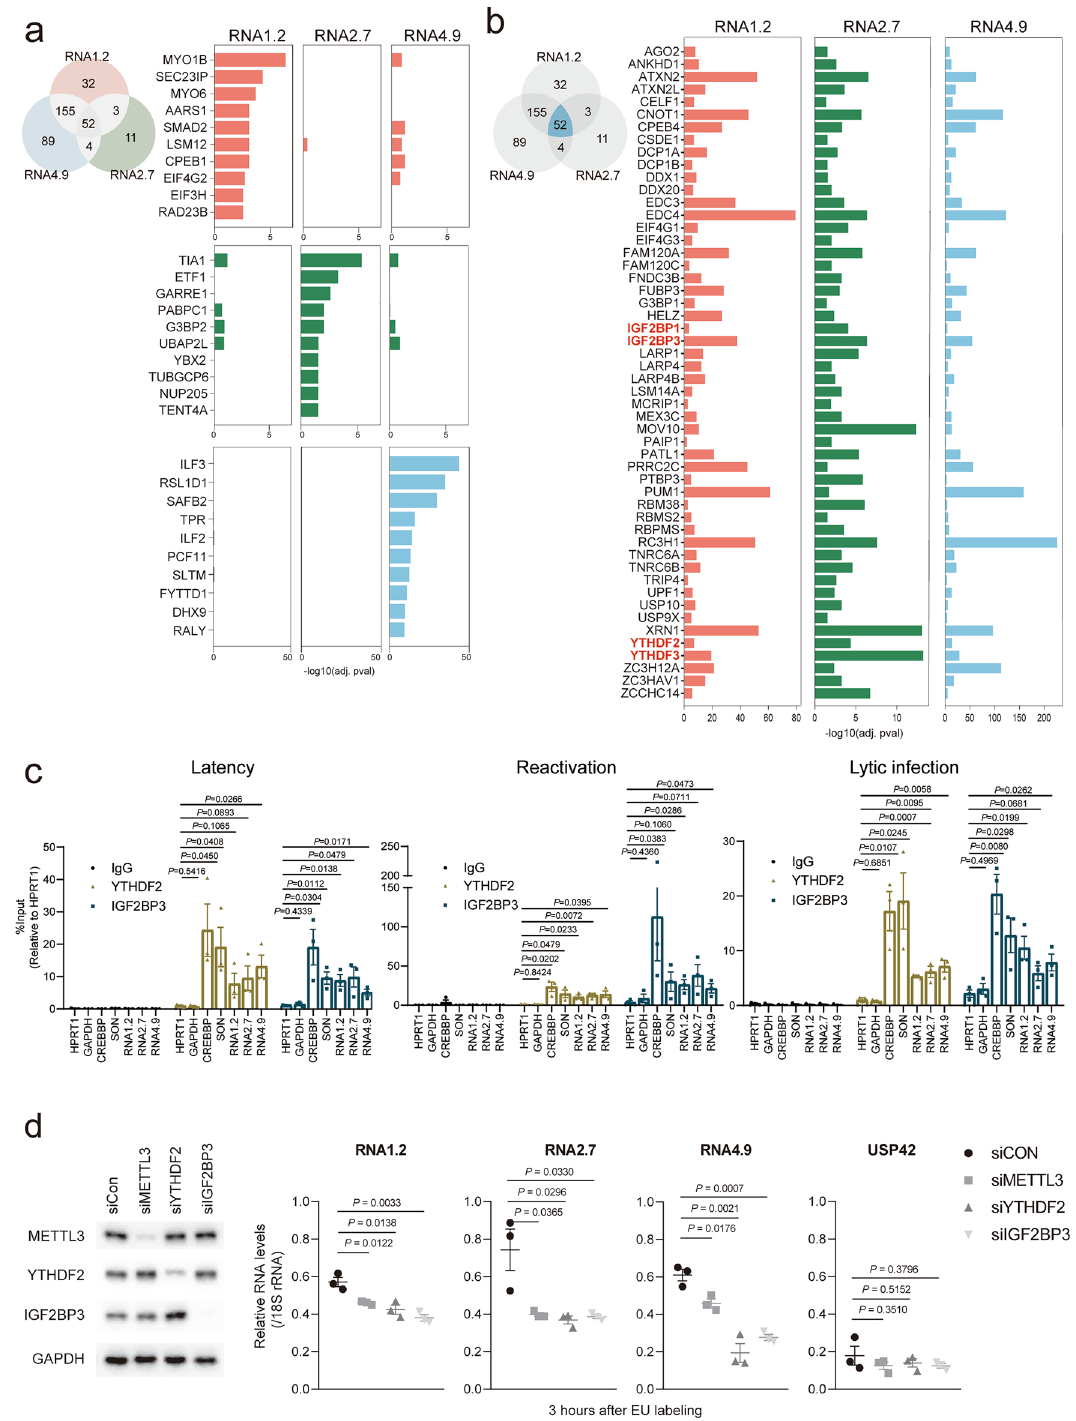
Figure 5. m 6 A readers interact with and stabilize RNA1.2, RNA2.7, and RNA4.9 ( a , b ) Significant binding proteins filtered by comparing with no probe and antisense-lncRNA targeting probe samples. Venn diagrams represent the number of significantly binding proteins. Top 10 lists of lncRNA-specific binding proteins in order of adjusted p-value are presented in ( a ), and common binding proteins of the three lncRNAs are presented in ( b ). ( c ) Enrichment of lncRNA in immunoprecipitation of YTHDF2 or IGF2BP3. HPRT1 and GAPDH served as negative controls for m 6 A modification; CREBBP and SON served as positive controls. ( d ) RNA1.2, RNA2.7, and RNA4.9 are stabilized by m 6 A readers. (Left) Protein expression of METTL3, YTHDF2, and IGF2BP3 in each gene targeting siRNA-treated HFFs. GAPDH served as a loading control. (Right) Stability of EU-labeled HCMV lncRNAs. USP42 served as a negative control. Data represents values relative to a 0 h sample. ( c , d ) Data represent mean ± SEM of independent experiments (n = 3); statistical significance was calculated by two-tailed unpaired t